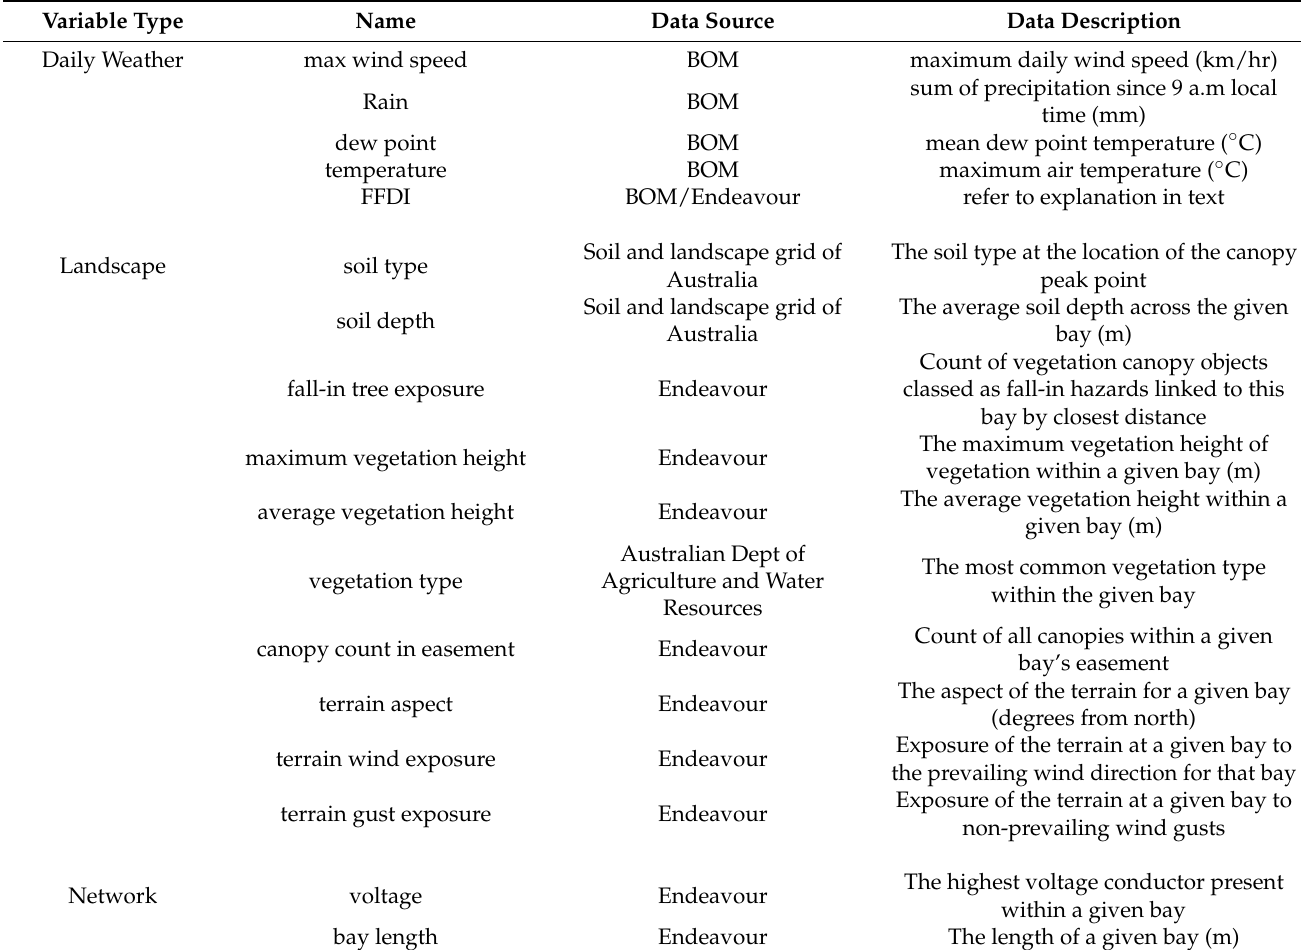
Table 1. Input features used for